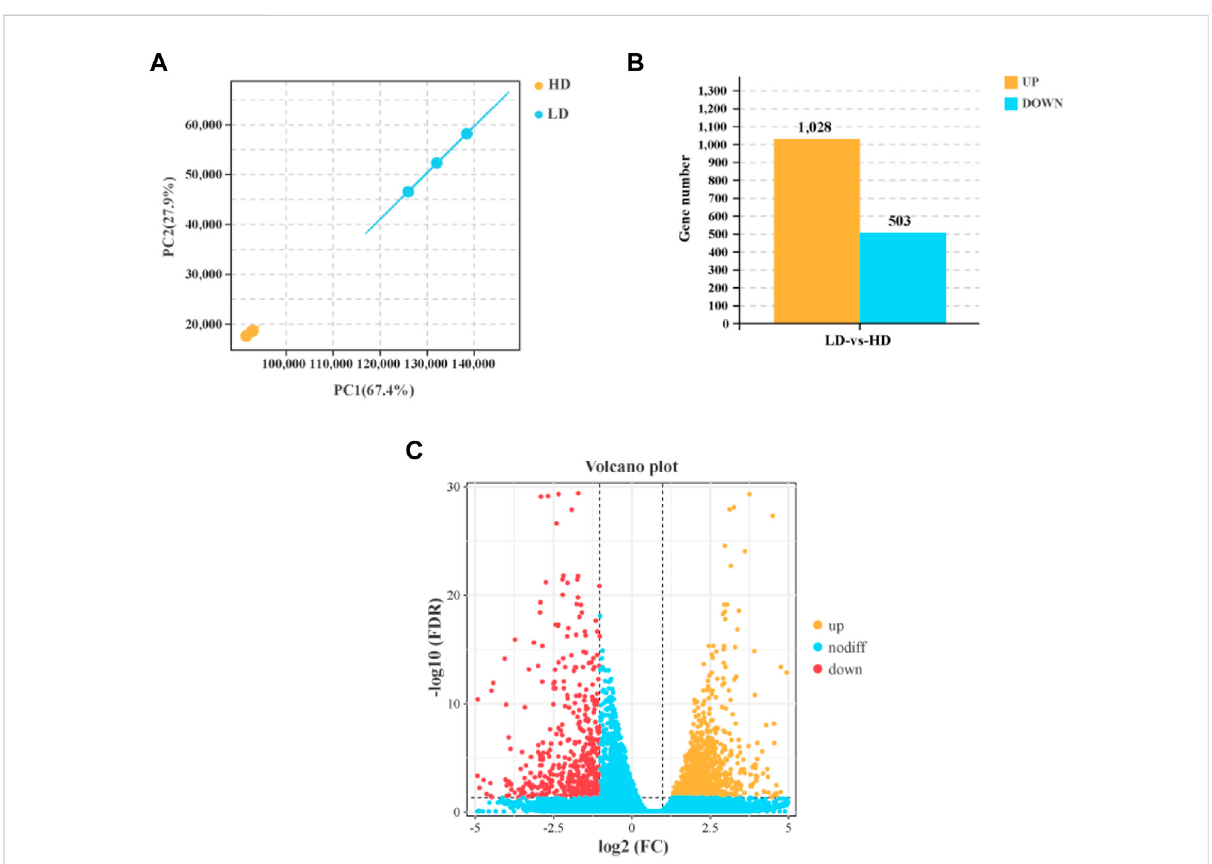
FIGURE 3 Differently expressed genes (DEGs) in the hepatopancreas of C. quadricarinatus between the LD and HD group. (A) The correlation of samples between the LD and HD groups. (B) The number of DEGs in the hepatopancreas between the LD and HD groups. (C) Volcano plot of DEGs between the LD and HD groups.